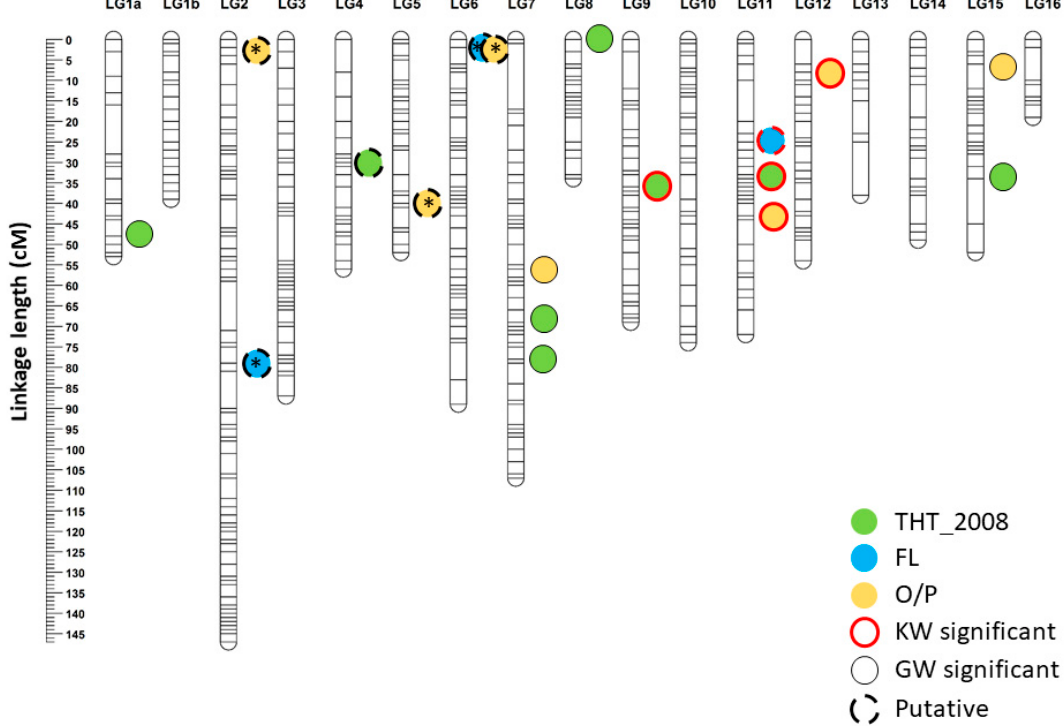
Figure 2. Distribution of quantitative trait loci (QTLs) for trunk height in 2008 (THT_2008), frond length (FL) and total oil per palm (O / P) on a linkage map of the GM-3341 family. KW significant—Kruskal-Wallis at the p = 0.005 threshold; GW significant—genome-wide logarithm of odds, to the base 10 (LOD) = 4.0 threshold; putative—2.4 ≤ LOD < 4.0 threshold; *non-cofactor.